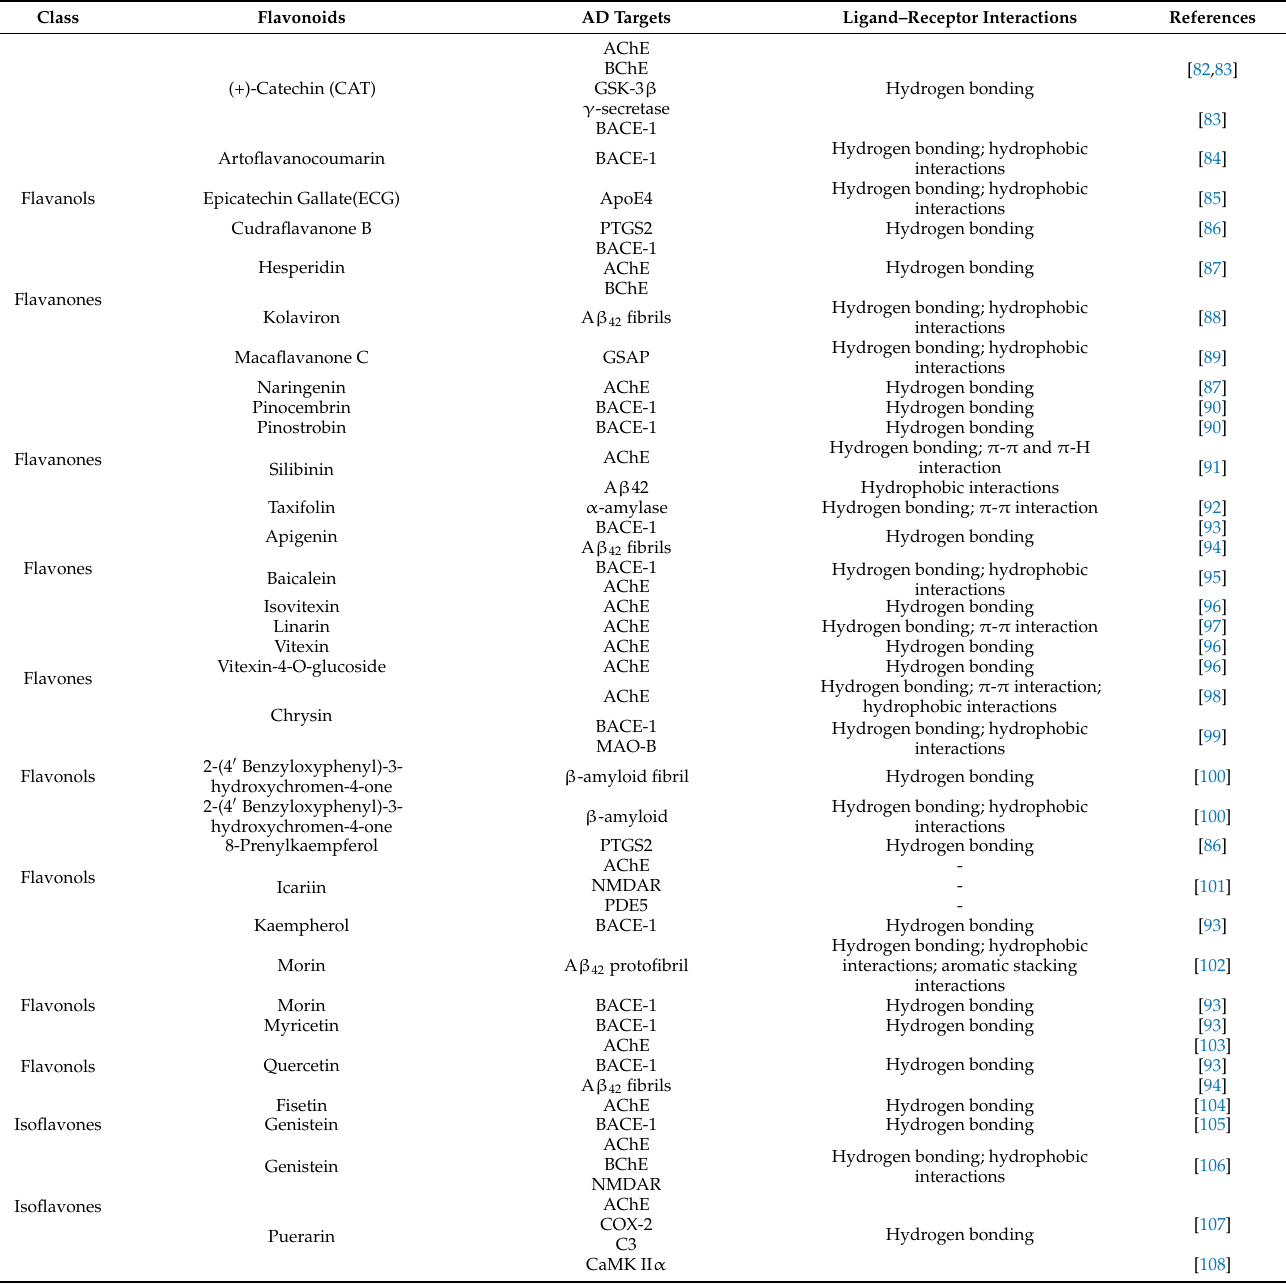
Table 3. Favorable effects of flavonoids against different AD targets in